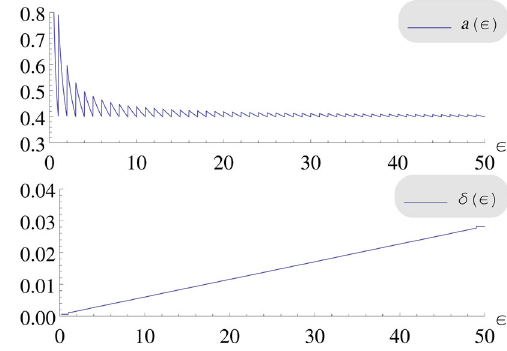
FIG. 1. We show a and δ as functions of ϵ for a binomial distribution of 2 × 10 6 randomly chosen bits (mean 10 6 , standard deviation ≈ 707 ).